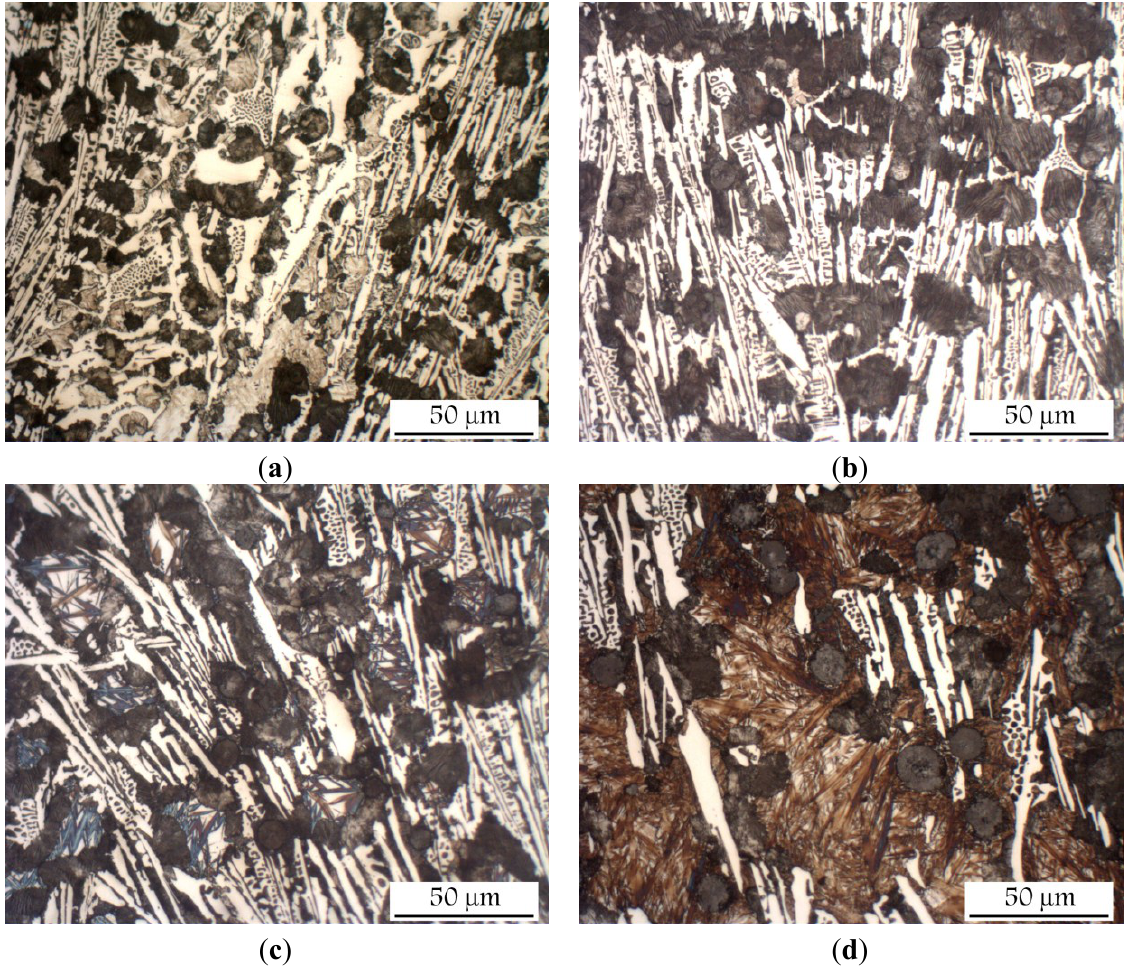
Figure 4. Solid fraction evolution of A1 samples. ( a ) A11 Sample; ( b ) A12 Sample; ( c ) A13 Sample; ( d ) A14